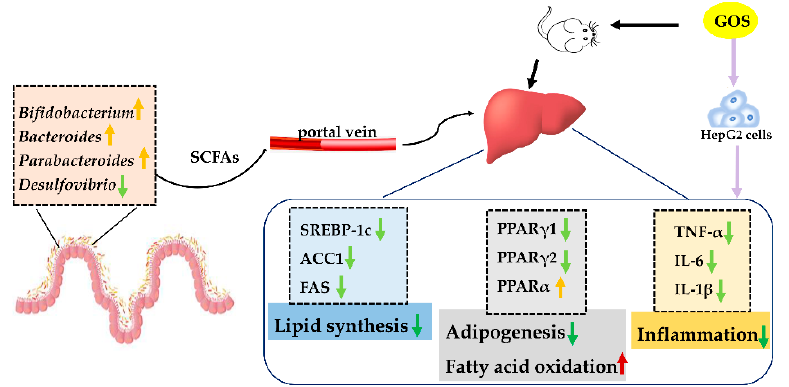
Figure 13. The mechanism of GOS improving liver lipid accumulation in mice. Light green arrows indicate downregulation, green arrows indicates decrease, yellow and red arrows indicate an increasing effect.